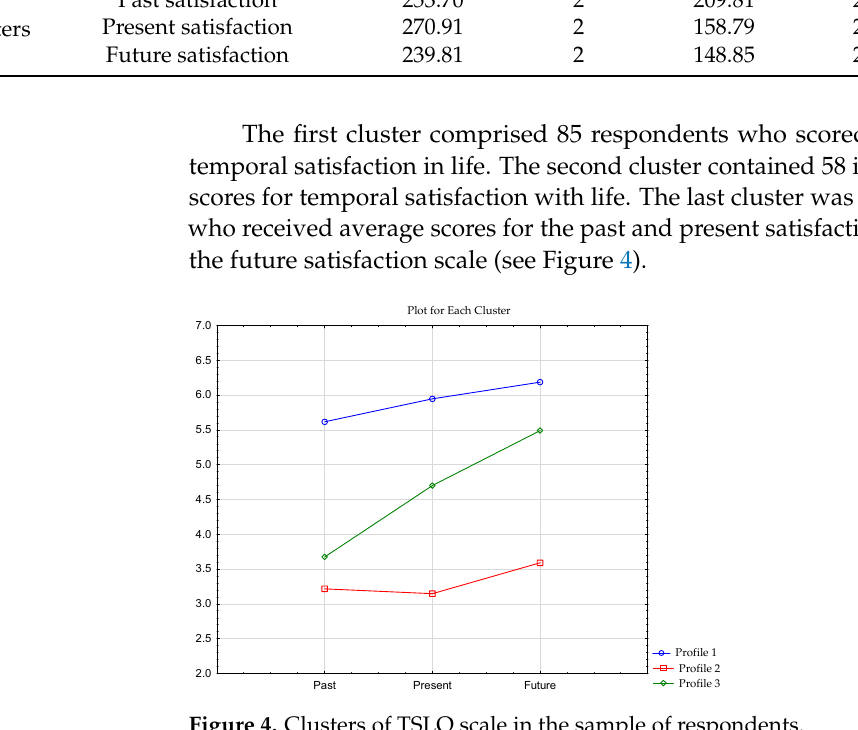
Table 5. Variance within and between groups for Psychological Capital Scale: results of k-means clustering analysis. Model